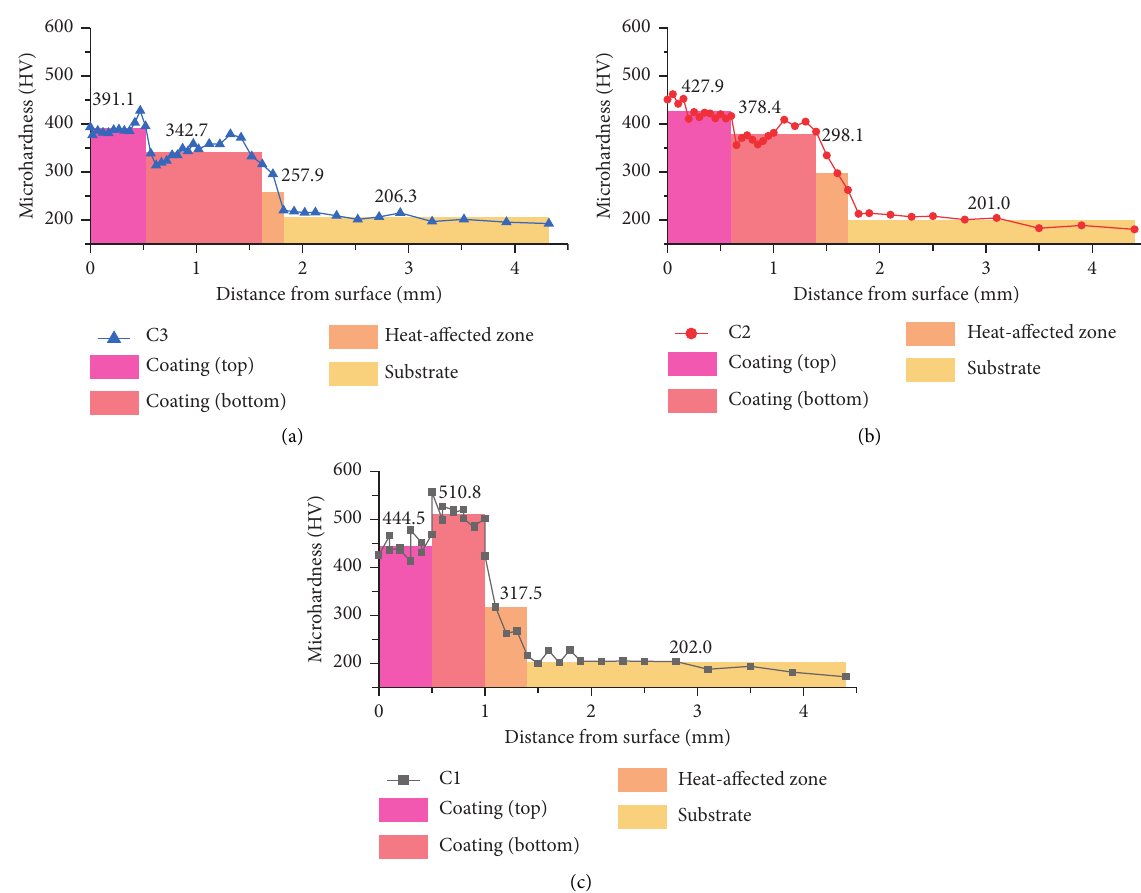
Figure 8: Microhardness distribution along the cross section of the as-prepared Ni45 coatings. The height and width of the colored rectangles represent the microhardness and the depth of different regions in the